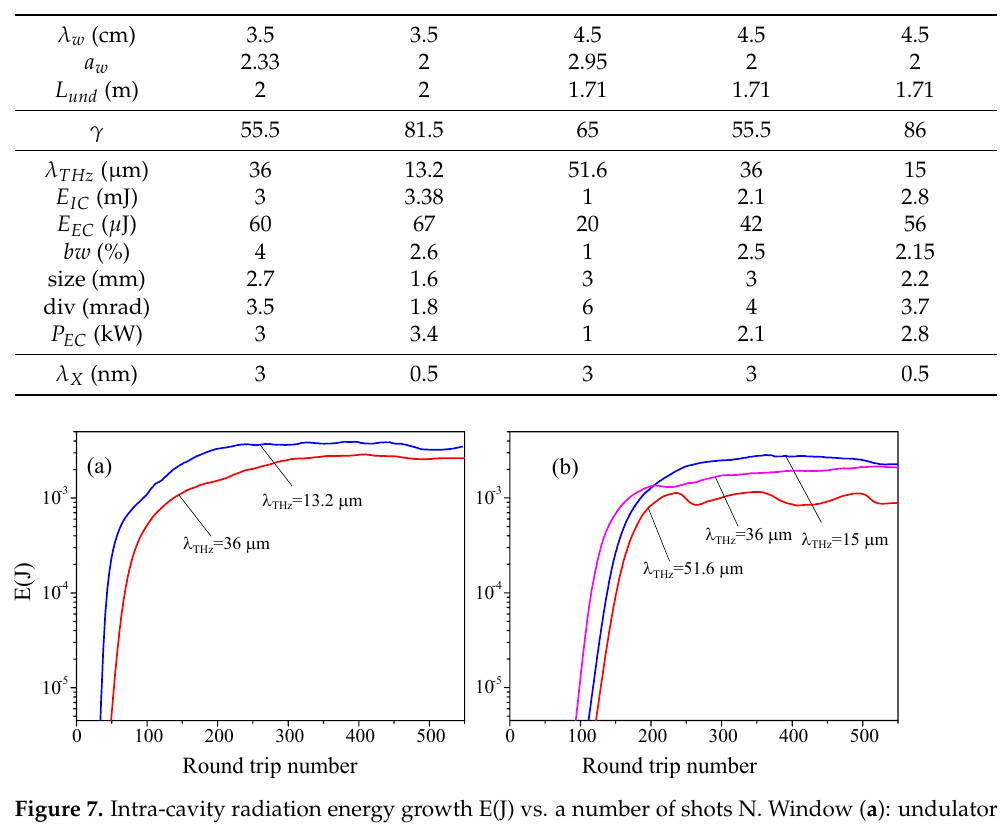
Table 2. THz radiation: undulator specifics, electron energy, and results (repetition rate at 5 × 10 7 Hz). E IC and E EC indicate the intra-cavity and extra-cavity radiation energy, respectively; size, div and P EC are the output radiation size, divergence and the extra-cavity radiation power level, respectively. Mirror losses at 2%.